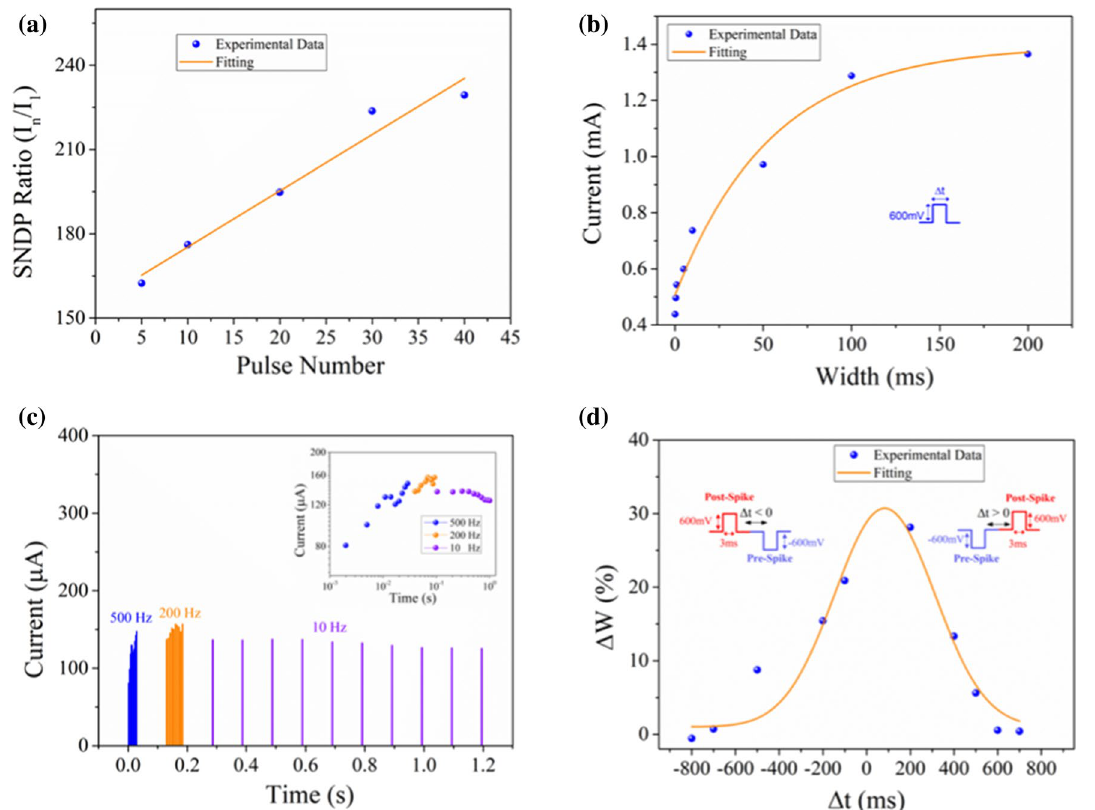
Fig. 4 ( a ) Spike-number-dependent plasticity (SNDP) Ratio as a function of pulse number. ( b ) Post-Synaptic Current as a function of pulse width (SWDP). ( c) SRDP measurement for 10,200 and 500 Hz frequency and current enhancement (inset). ( d ) Experimental evidence of